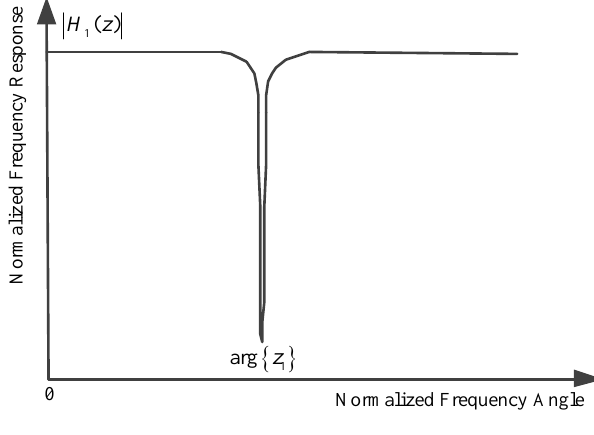
Figure 1. Normalized frequency response of one order complex-coefficient adaptive notch filter